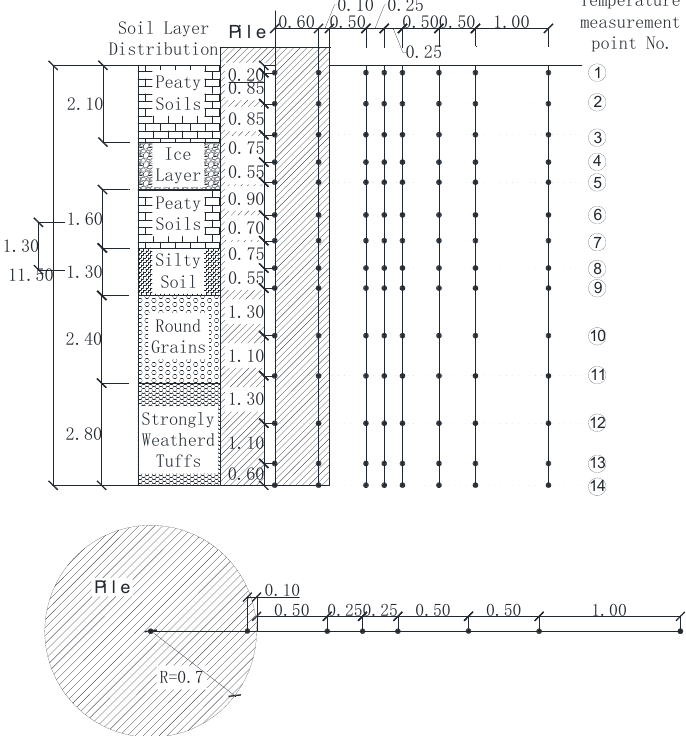
Figure 1. 1# test pile temperature measurement point layout diagram.